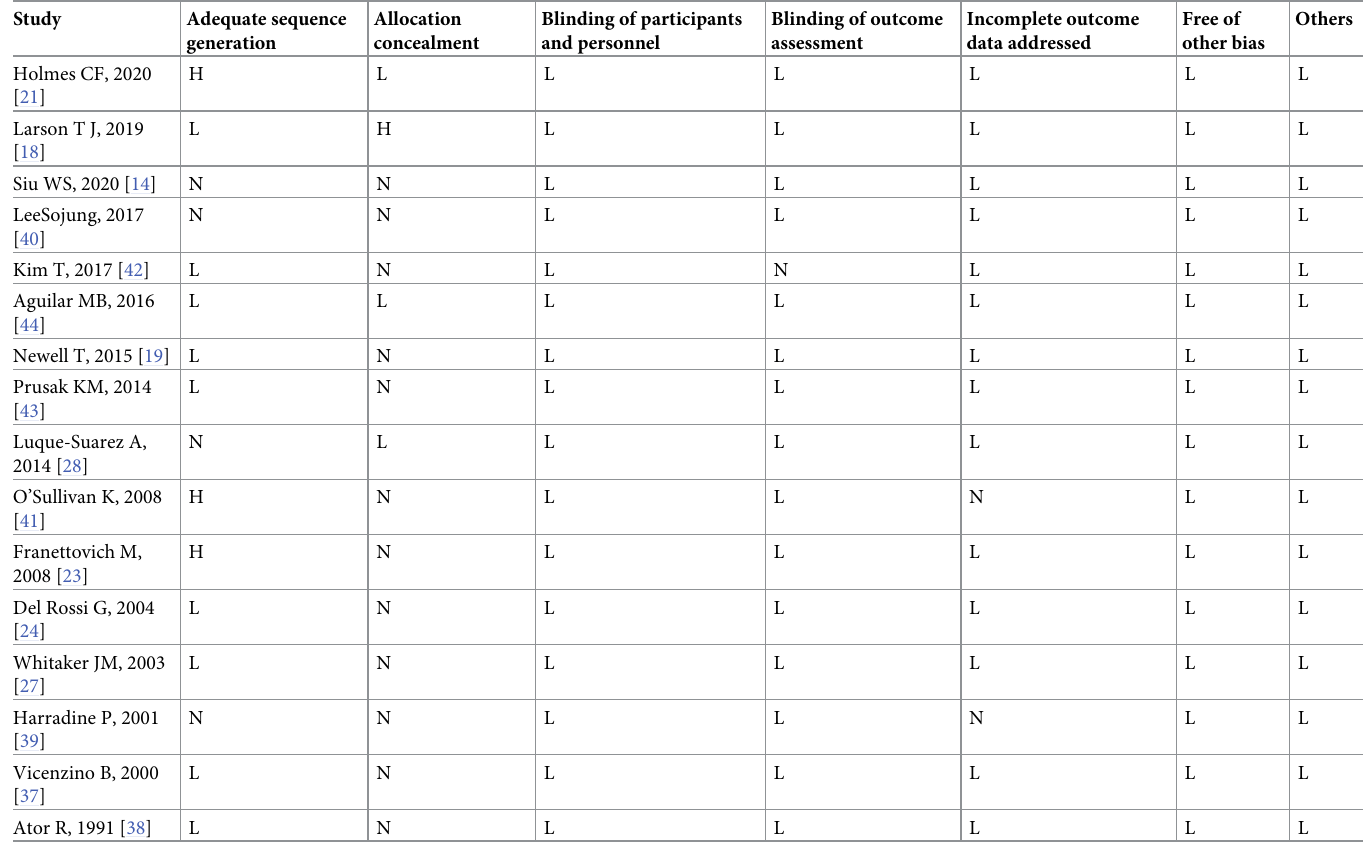
Table 3. Cochrane criterion score of included